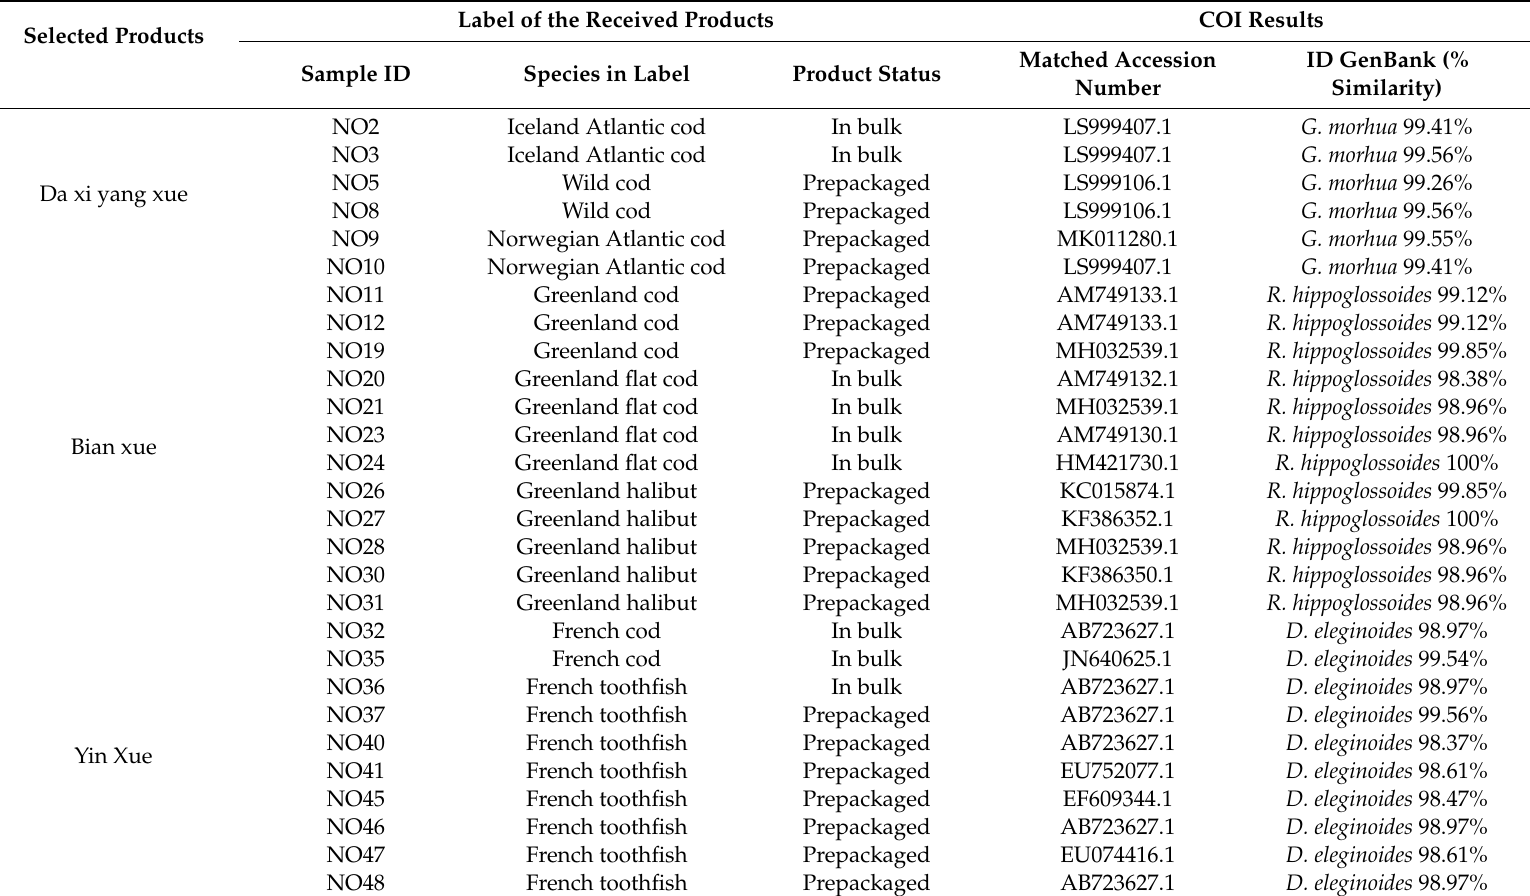
Table 1. The successful identification samples and the sequences blast